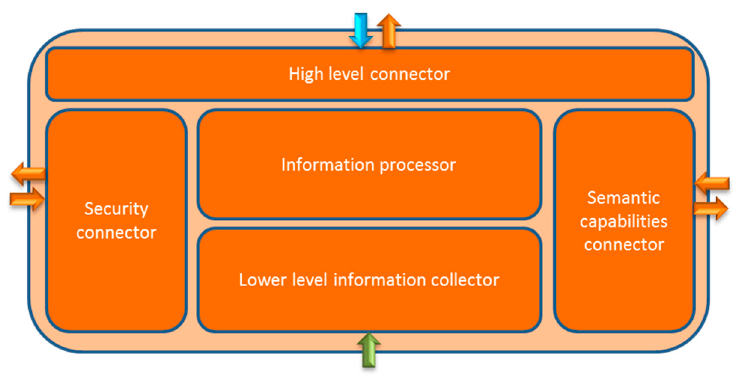
Figure 6. Data processing done in the Context Awareness module.